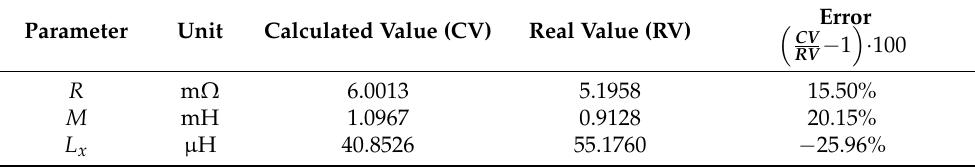
Table 5. The experimental results with two sinusoidal current test signals and measured voltage.